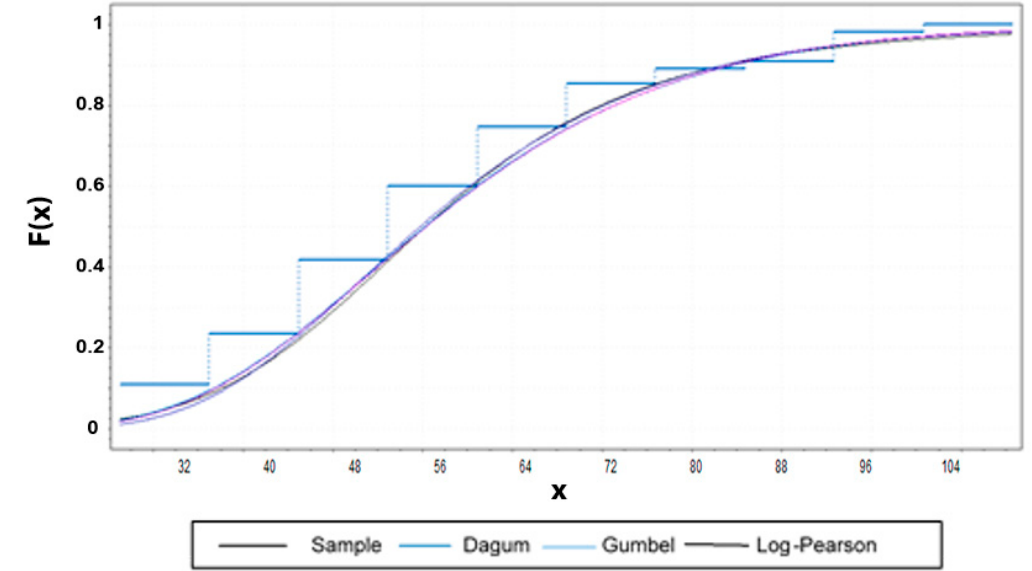
Figure 6. Cumulative distribution functions of Gumbel, Log-Pearson type III and Dagum distributions, applied to the histogram of data from San Vicente de Alcántara.